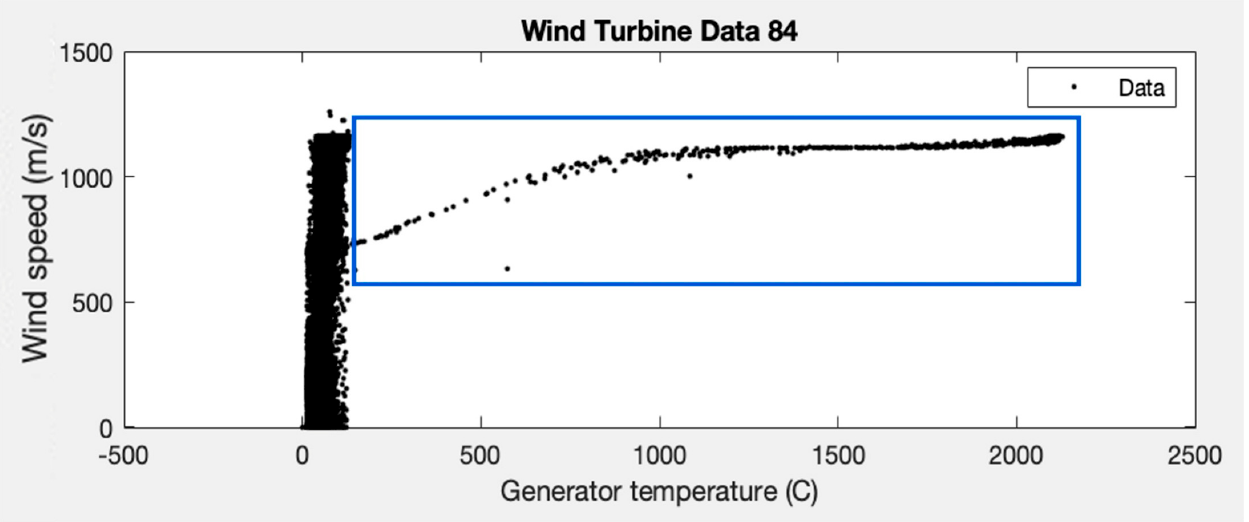
Figure 2. Erratic behaviour of the wind turbine 84 for the wind speed and the generator temperature variables.